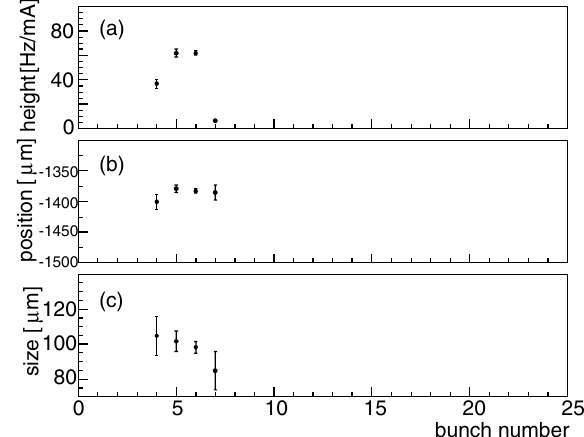
FIG. 9. Bunch dependence of the 3-bunch beam (horizontal measurement). (a) The peak height; (b) the horizontal peak ; (c) the peak width (cid:11) (cid:5) x (cid:6) meas . position x p